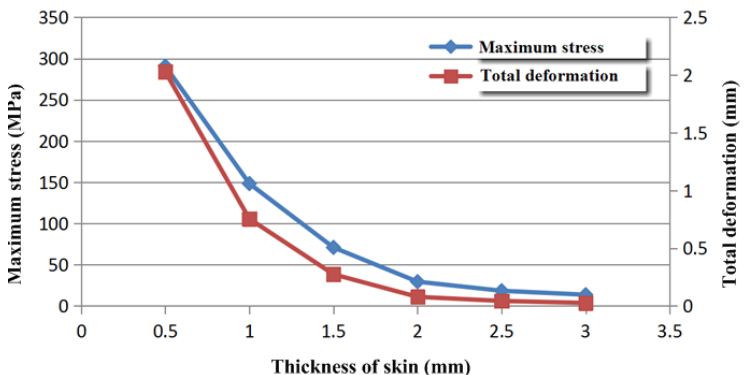
Figure 8. Stress and strain of skin under load of 1000 N.